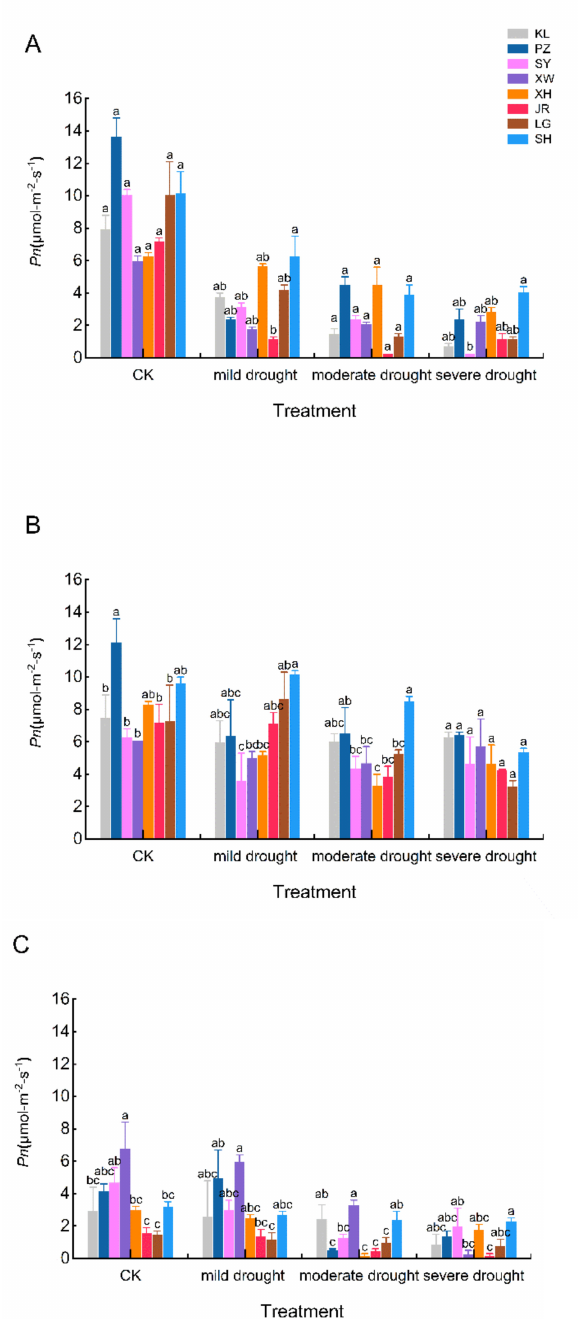
Figure 3. The net photosynthetic rate of Melia azedarach among different provenances: ( A ): early stage ( B ): middle stage, and ( C ): late stage. Note: The error line in the figure is the mean ± standard error, and different lowercase letters in the same treatment indicate significant differences at the 0.05